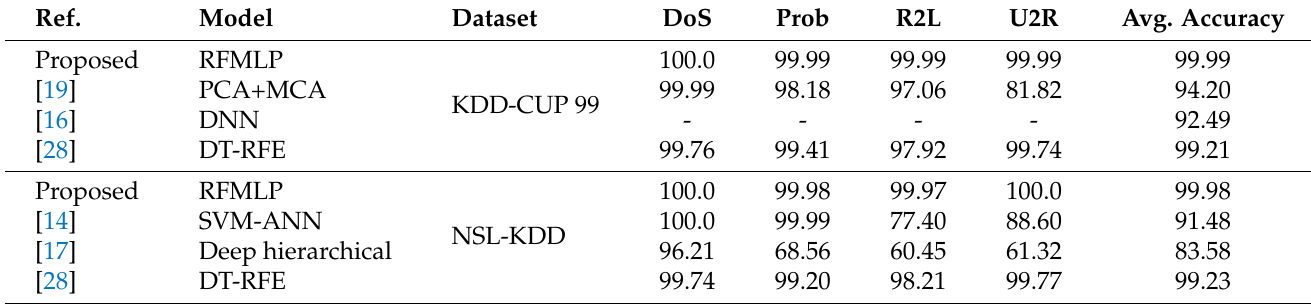
Table 11. Accuracy comparison of classifiers on KDD-CUP and NSL-KDD datasets.